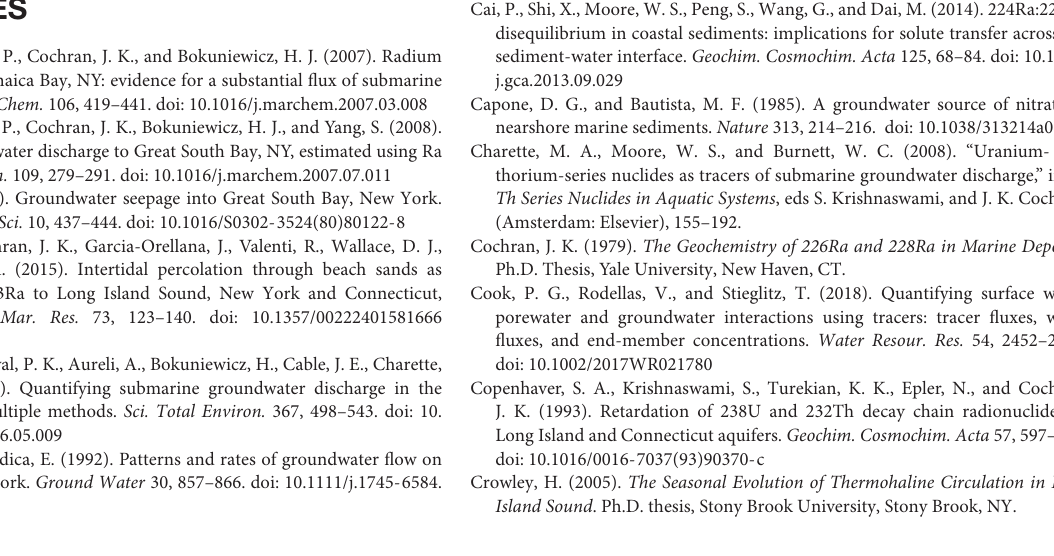
TABLE S1 | Summary of Ra isotope mass balances, arranged by basin and